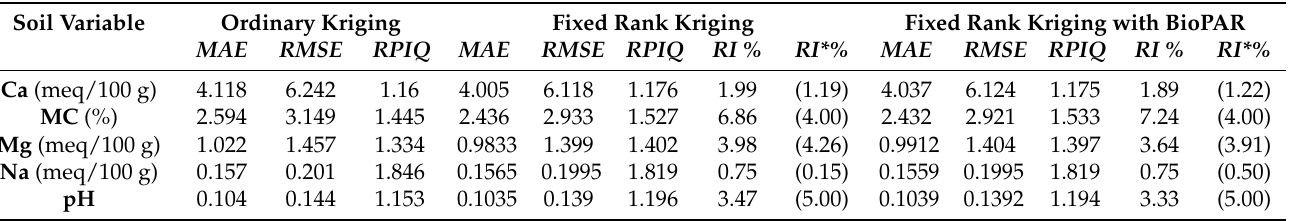
Table 8. Validation summary of the three interpolation methods (OK, FRK, FRK-BioPAR) for different soil properties (n = 100 validation